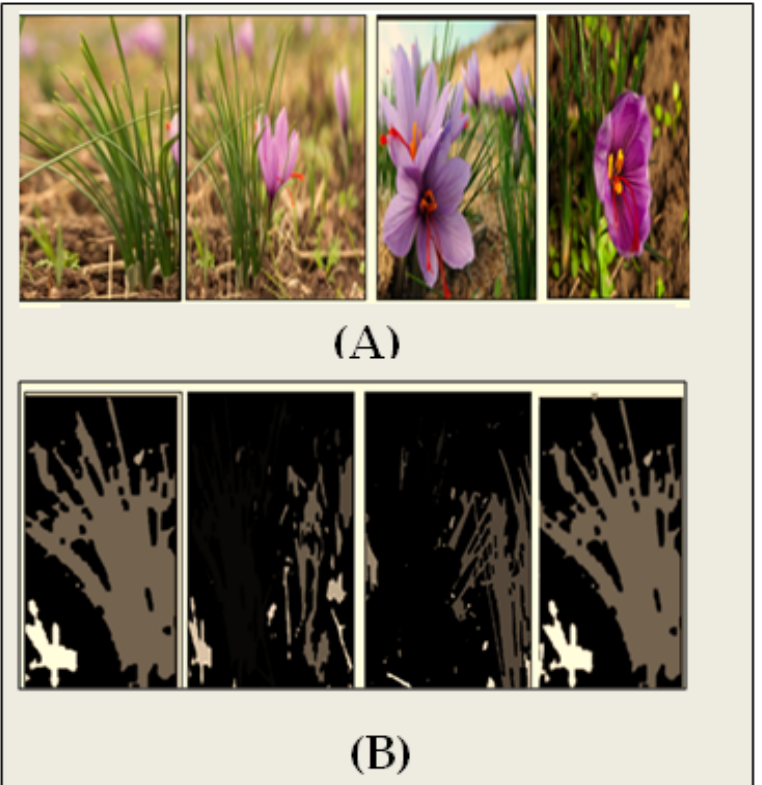
Figure 8. Canopy cover development in different stages of saffron growth. ( A ) Images shot by camera; ( B ) images processed by software.